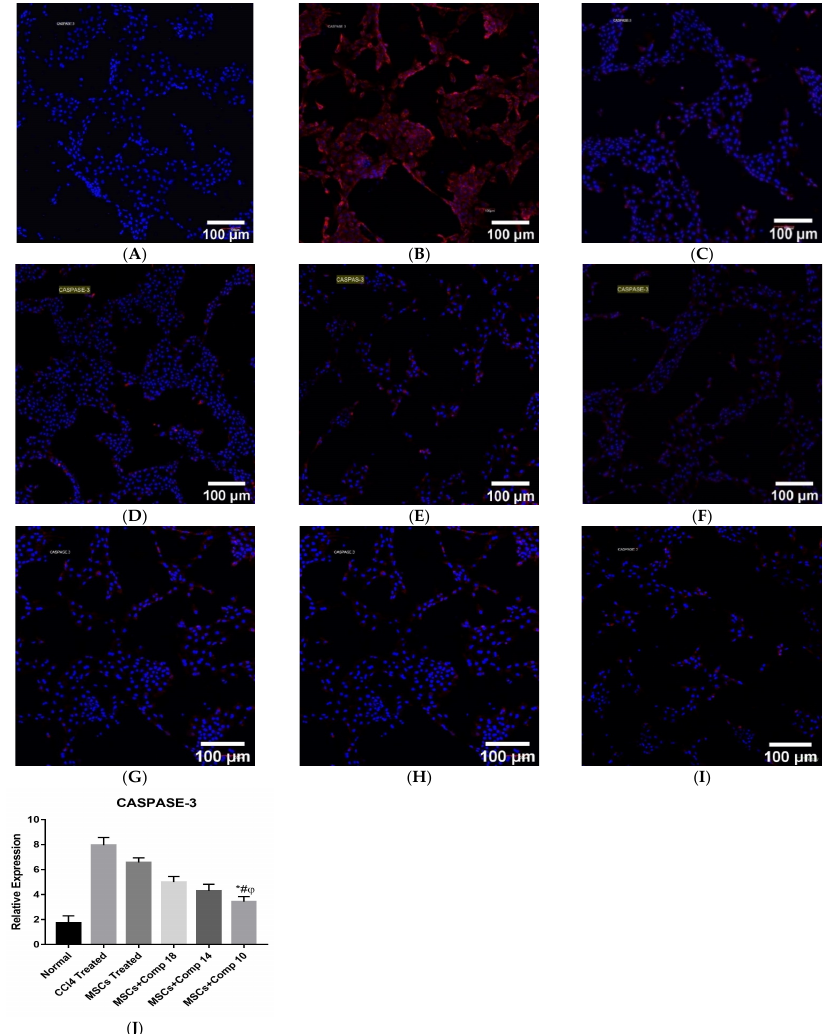
Figure 3. Immunostaining for the detection of Caspase-3 in in vitro co-cultured hepatocytes model: ( A ) normal, ( B ) CCl 4 ‐ treated, ( C ) compound ( 18 ), ( D ) compound ( 14 ), ( E ) compound ( 10 ) ‐ treated hepatocytes, ( F ) MSCs ‐ treated, ( G ) MSCs + compound ( 18 ), ( H ) MSCs + compound ( 14 ), ( I ) MSCs + compound ( 10 ), ( J ) graphical representation of fluorescence intensity of caspase ‐ 3 in all groups. Expression of caspase-3 protein was significantly decreased in MSCs + compound ( 10 )-treated hepatocytes, compared to all other groups, shown by bar with symbols *. Mean ± SEM (n = 3). Bars with symbols show significance with each other. * p < 0.02 for MSCs + Comp10 vs. CCl 4 ; # p < 0.05 for MSCs + Comp10 vs. MSCs; ϕ p < 0.05 for MSCs + Comp10 vs. MSCs + Comp18 &